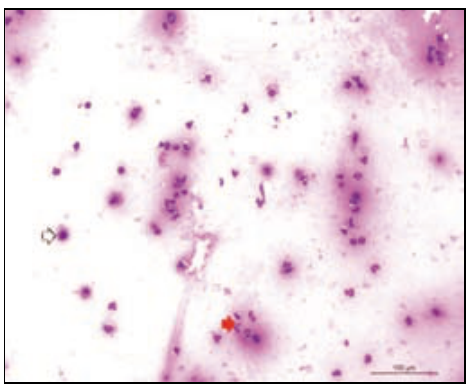
Fig. 1 Endometrial cytology in dairy cows (100X)